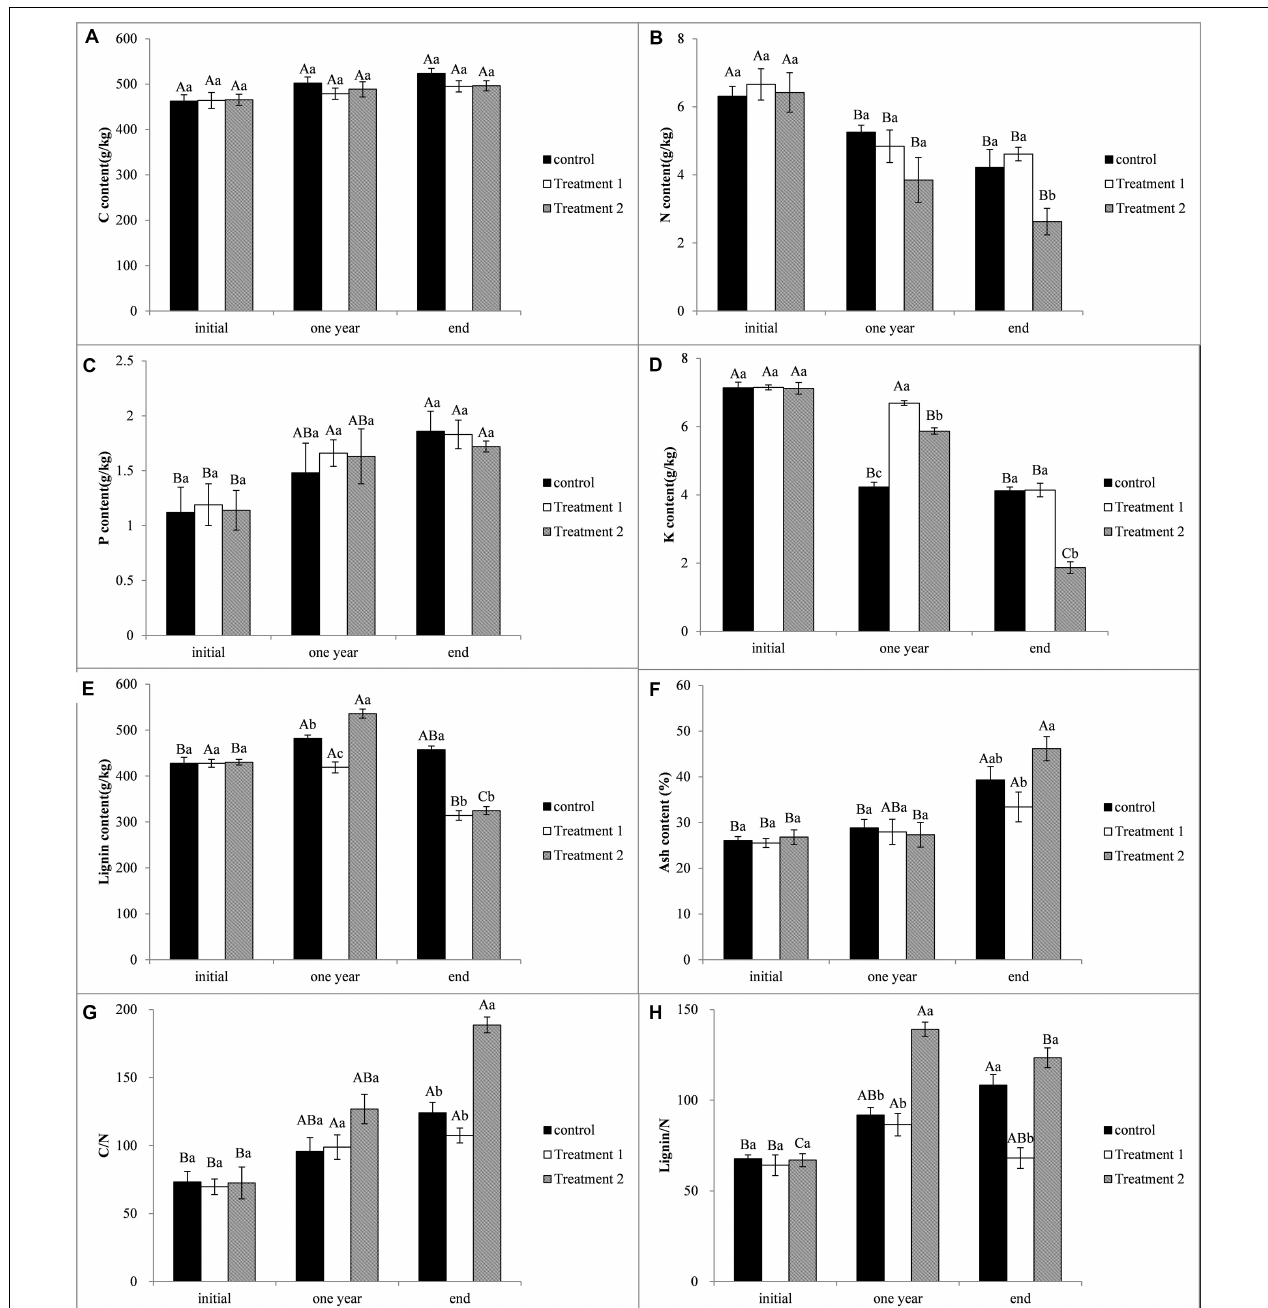
FIGURE 4 | Initial traits of Stipa klemenzii leaf litter. (A) C content; (B) N content; (C) P content; (D) K content; (E) Lignin content; (F) Ash content; (G) C/N ratio; (H) Lignin/N ratio. Bar heights (means) ± error bars (1 SE). Mean values with different lowercase letters are significantly different among the different treatments at P < 0.05; mean values with different uppercase letters are significantly different among the different retrieval times at P < 0.05. Treatment 1, decreased precipitation amount by 2/3 in the growth season (May 1–August 31); Treatment 2, increased precipitation interval in the early stage of growth season (May 1–June 30); control, natural